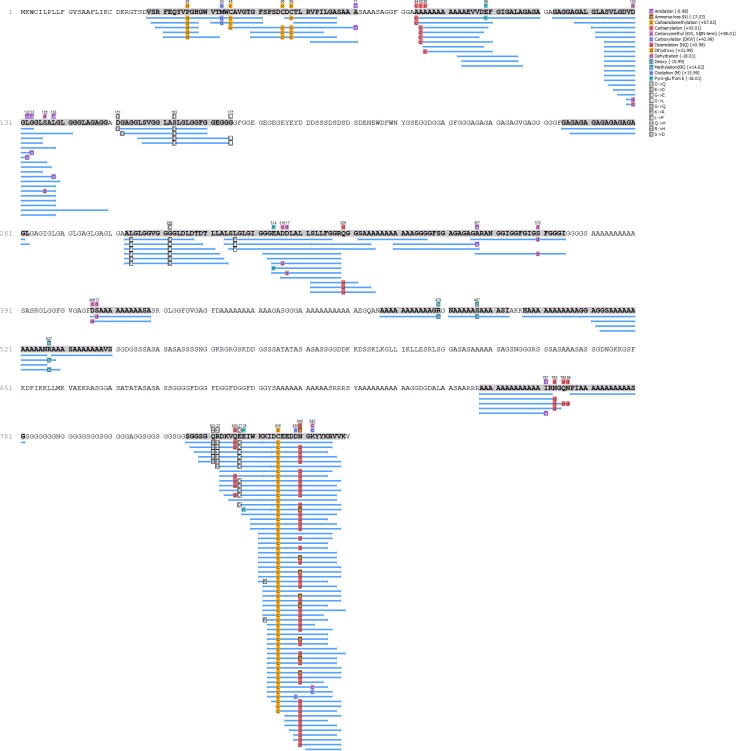
Pseudunio auricularius - Hic74 coverage.